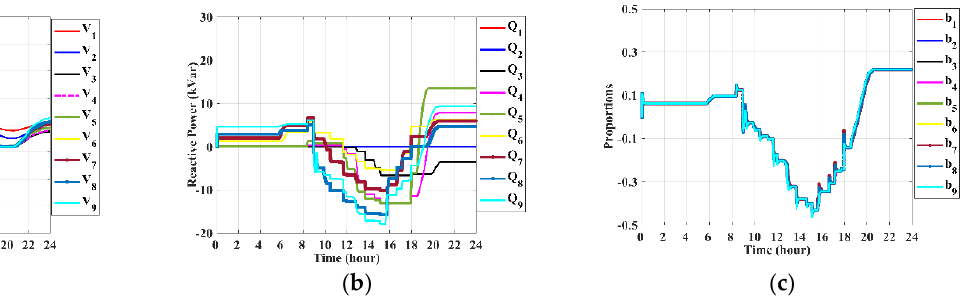
Figure 6. Nodal voltage magnitudes with reactive power sharing: ( a ) Nodal voltages; ( b ) reactive power of PV sources; ( c ) reactive power ratio of PV sources.